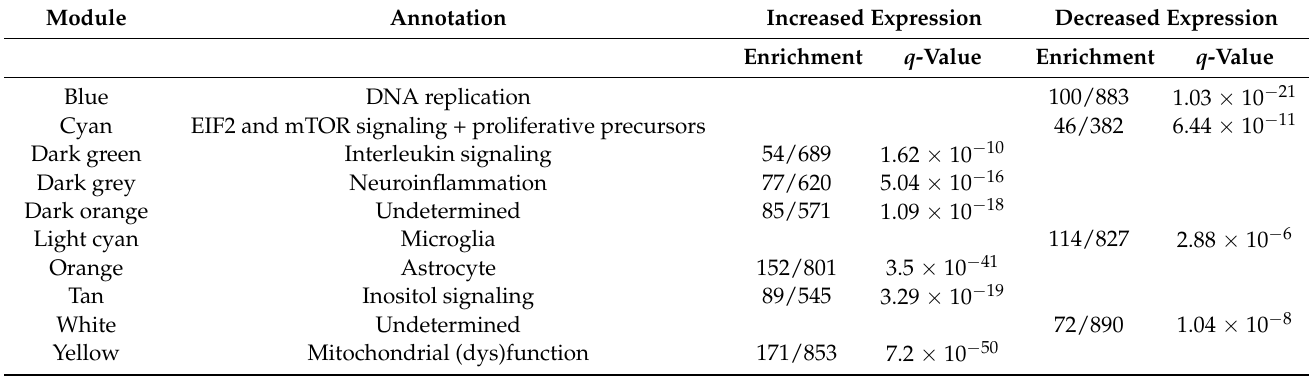
Table 1. Annotation of DEG-enriched WGCNA modules. The ten WGCNA modules that are significantly enriched in increased or decreased differentially expressed genes after AA exposure from RNA sequencing, using Fisher’s exact test with BH correction p < 0.05. Showing the annotation of each module based on cell type determination and IPA analysis, the enrichment of differentially expressed genes, module length, and the q-value from Fisher’s exact test. Annotation Increased Expression Decreased Expression Enrichment q